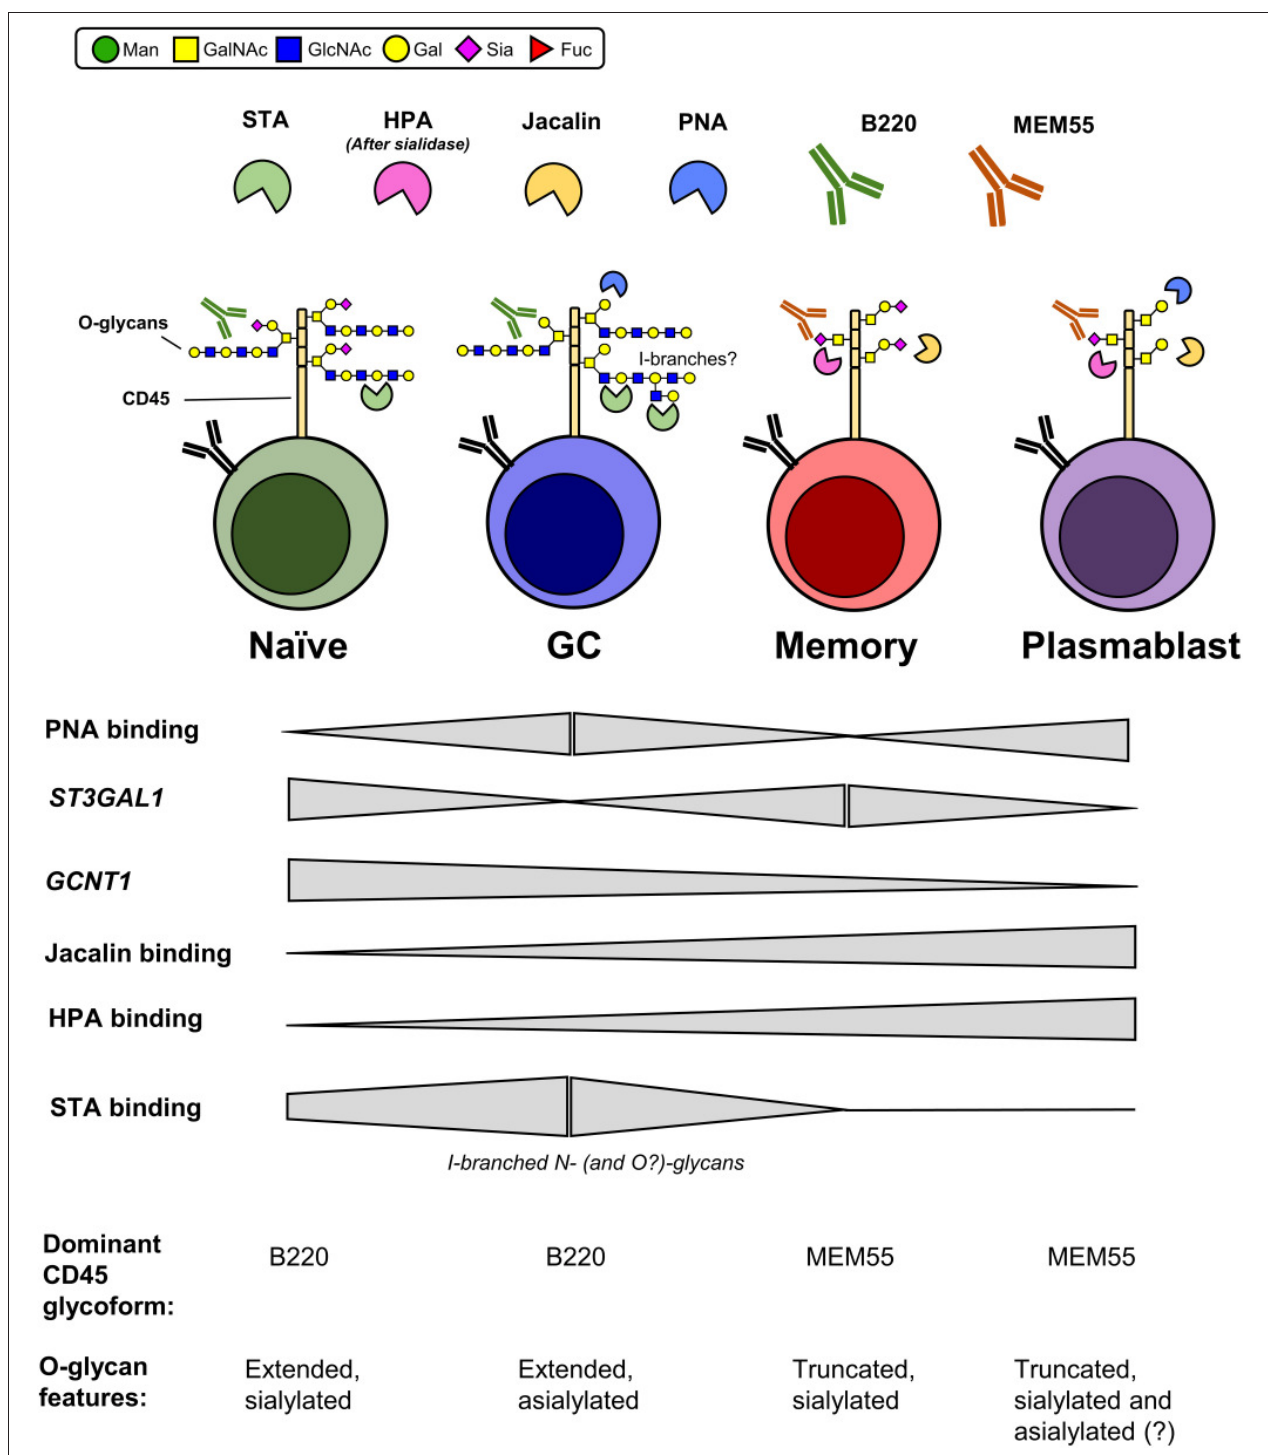
FIGURE 9 | Proposed O-glycosylation phenotype of human B cell subsets and expression of associated CD45 glycoforms. Summary of relative plant lectin binding, glycosyltransferase gene expression, and expression of CD45 mAb-reactive glycoforms for each B cell subset, as determined in the present study. Glycan features that are inconclusive are marked with a “?”. Man, mannose; GalNAc, N-acetylgalactosamine; GlcNAc, N-acetylglucosamine; Gal, galactose; Sia, sialic acid; Fuc, fucose.